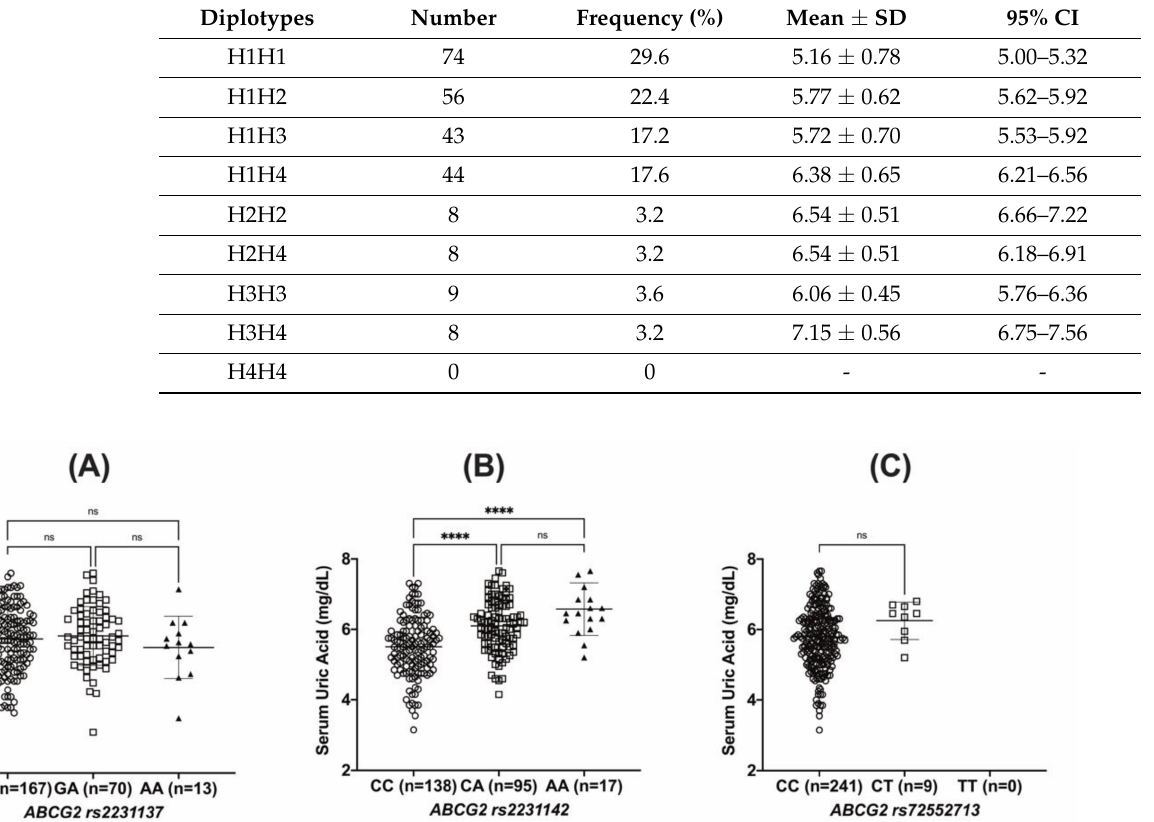
Table 4. Frequencies and observed serum uric acid levels according to the diplotypes of ABCG2 rs2231142 and SLC2A9 rs3733591.